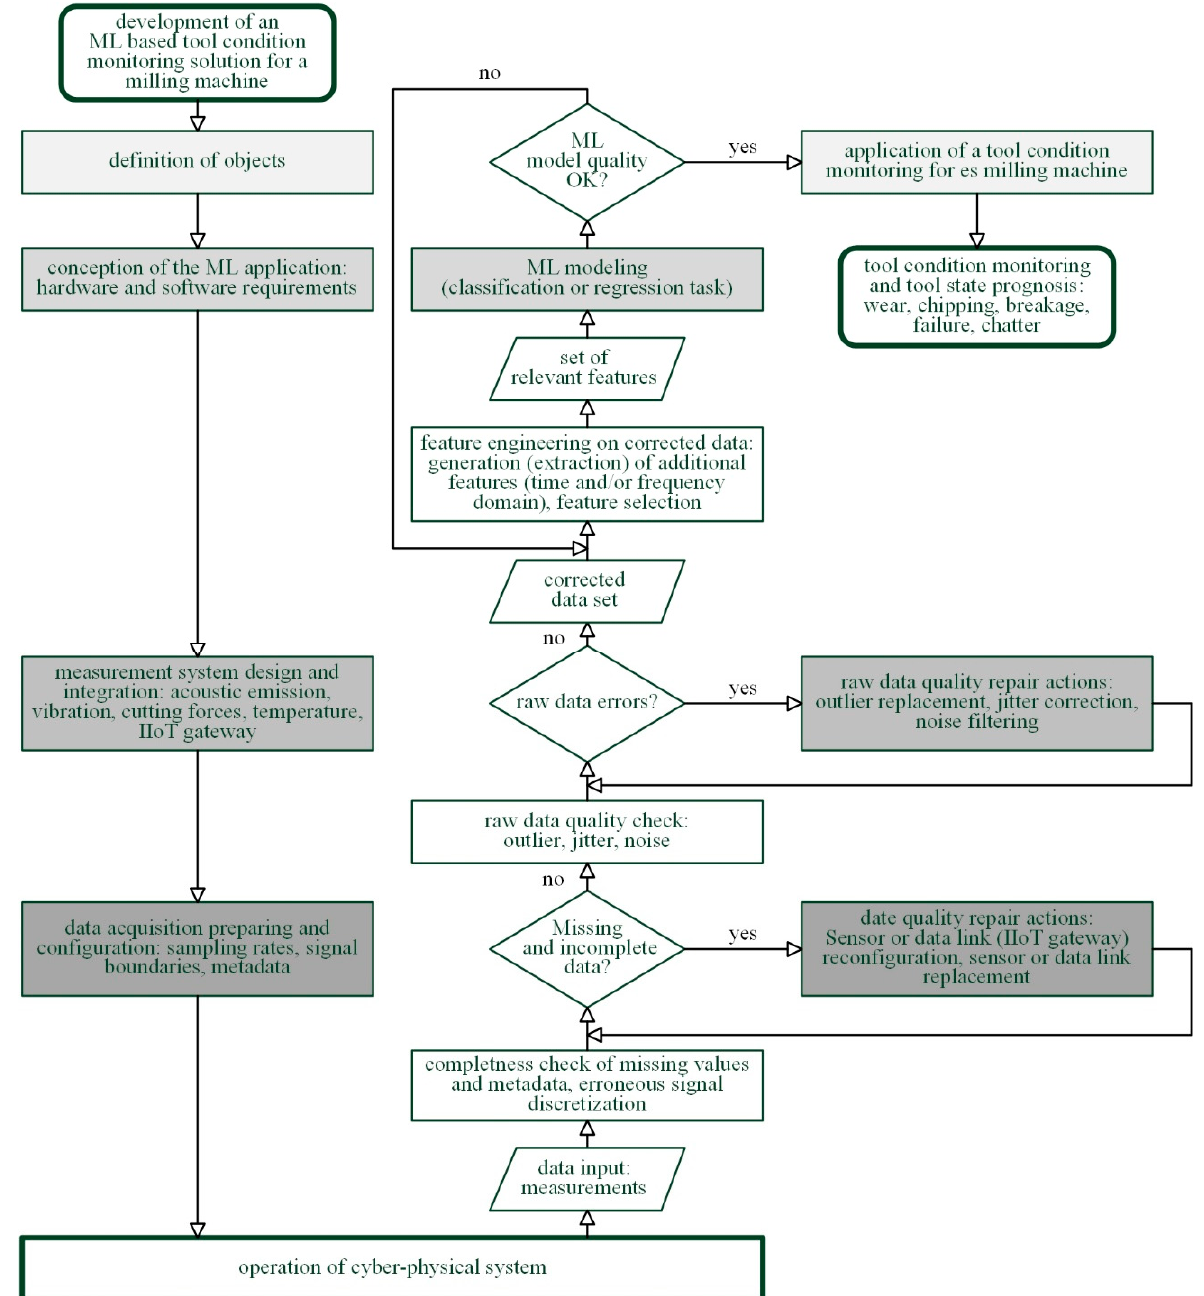
Figure 6. Application of the holistic quality assurance approach on the example of tool condition monitoring.